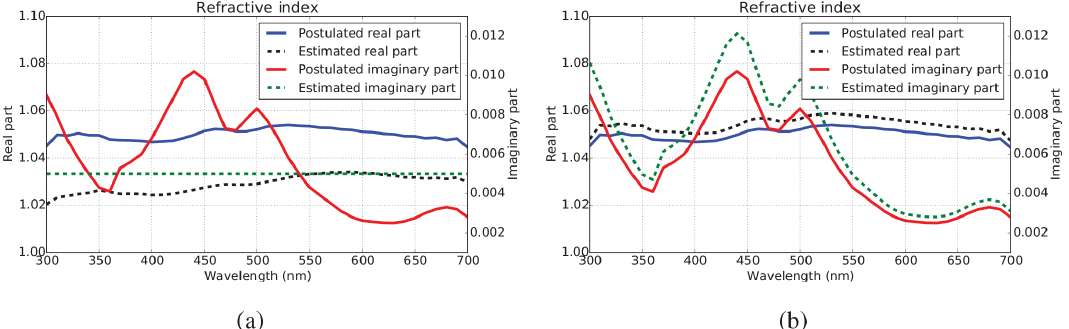
Figure 6. Postulated and estimated refractive indices using (a) the Twardowski and (b) the Stramski models.